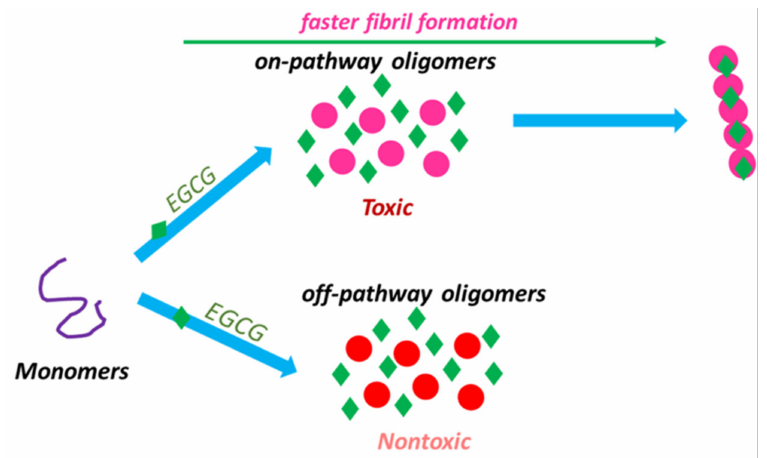
Figure 4. Schematic illustration showing the effect of EGCG on α -syn aggregation. EGCG induces the formation of two distinctive types of α -syn oligomers. The accelerated amyloid fibril formation is also observed in the presence of